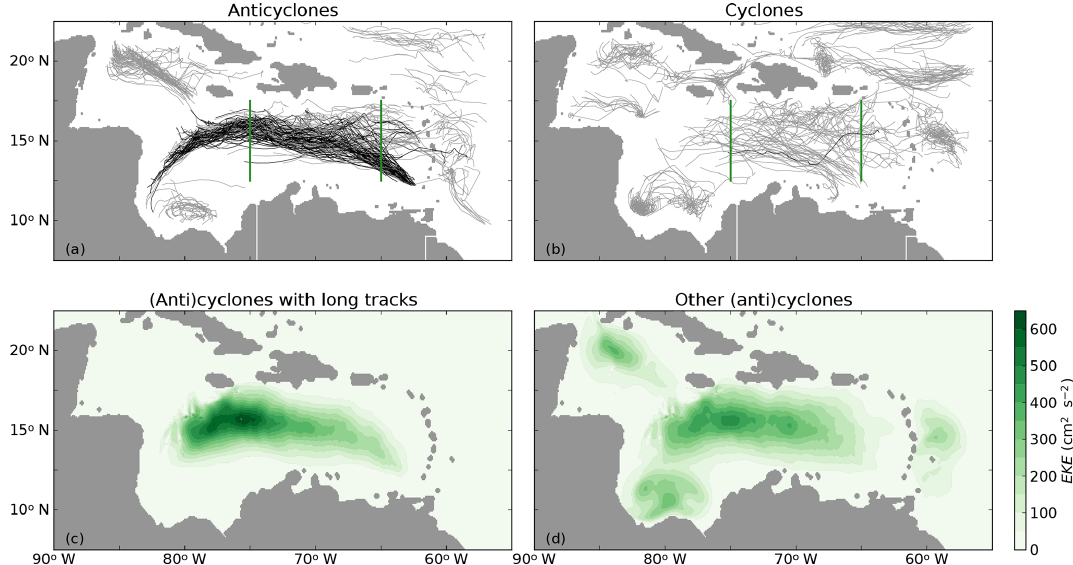
Figure 6. Paths of (a) anticyclones and (b) cyclones that are identified by the py-eddy tracker (Mason et al., 2014) in Ekman100 during 20 years of model simulation. The black lines indicate tracks that pass both cross sections at 65 and 75 ◦ W (green lines). All other tracks are indicated in grey. (c) Estimate of EKE (cm 2 s − 2 ) of the long tracks (black lines in panels a and b ). (d) Estimate of EKE of all other tracks (grey lines in panels a and b